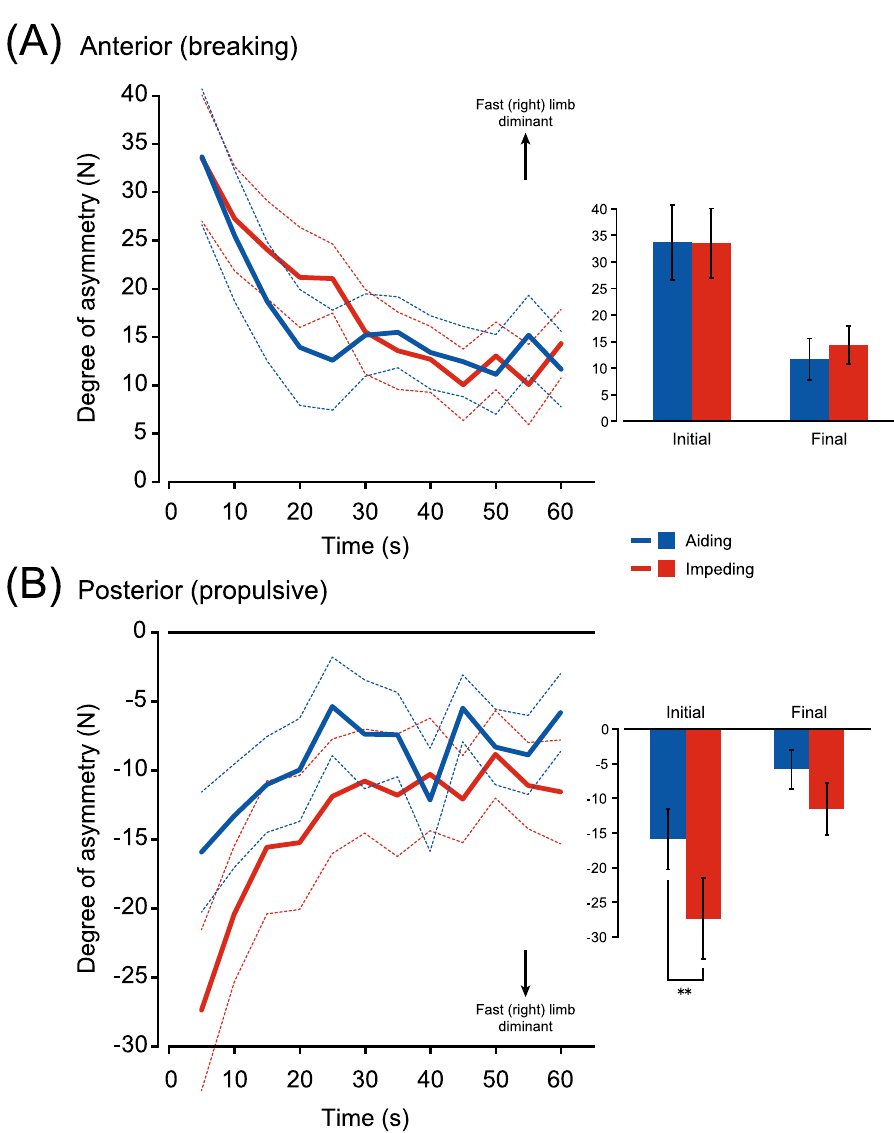
Figure 6. Comparison of the after effect sizes in the braking component ( A ) and the propulsive component ( B ) of the GRF between walking with aiding (blue lines) and impeding (red lines) force fields after adaptation to the impeding force field. Over the 1 min washout period, data were averaged for every 5-s bin. Data of eight subjects were obtained during washout 1 (corresponding to ➅ or ➈ in Fig. 1B), while those of the other eight subjects were from washout 2 ( ➆ or ➉ ) to overcome the ordering effects (n = 16). Lines show the mean (solid) and standard error of the mean (dotted), respectively. The bar graphs highlight the initial and final 5 s of the 1 min washout period. The error bars are the standard error of the mean. **P <